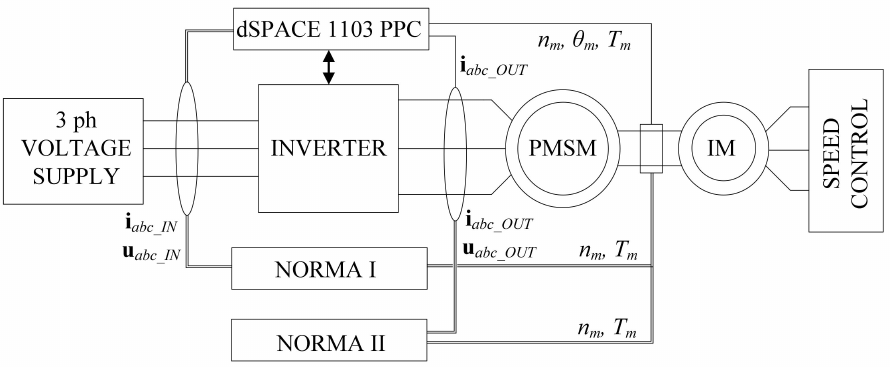
Figure 6. Experimental set-up—schematic presentation.